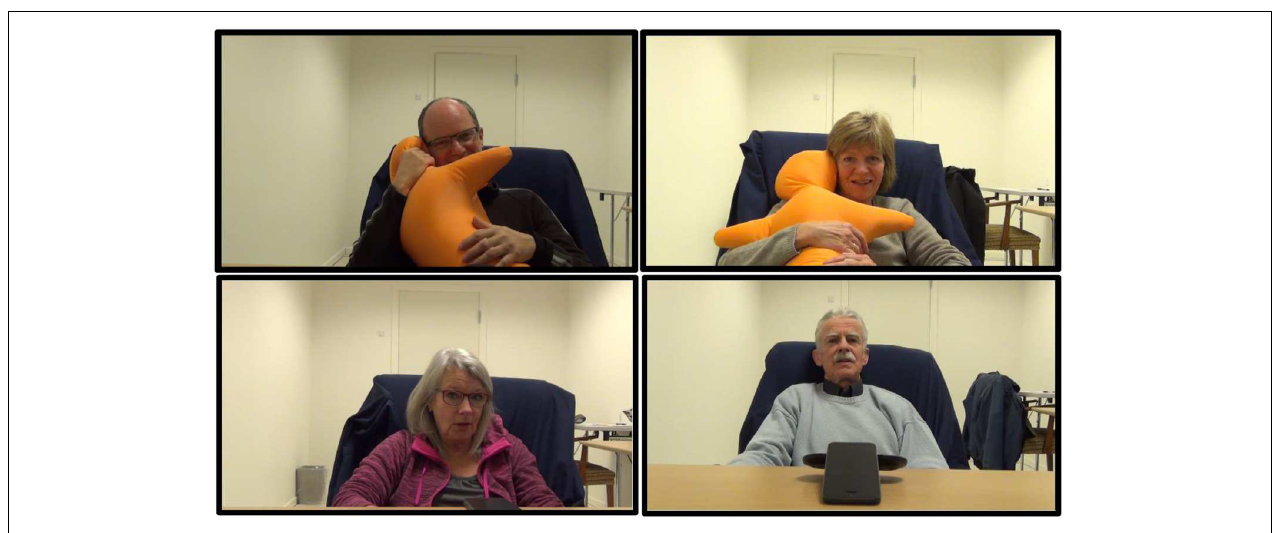
FIGURE 2 | Experimental settings.